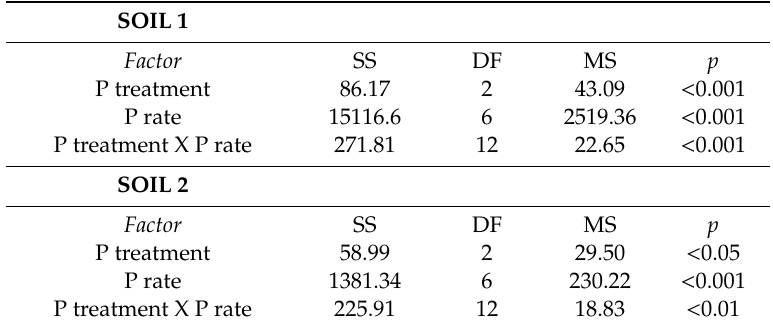
Table 2. Analysis of variance results. Effects of P treatment and P rate on As desorption in two soils (N = 3). SS: Sum of Squares, DF: Degrees of Freedom, MS: Mean Square.